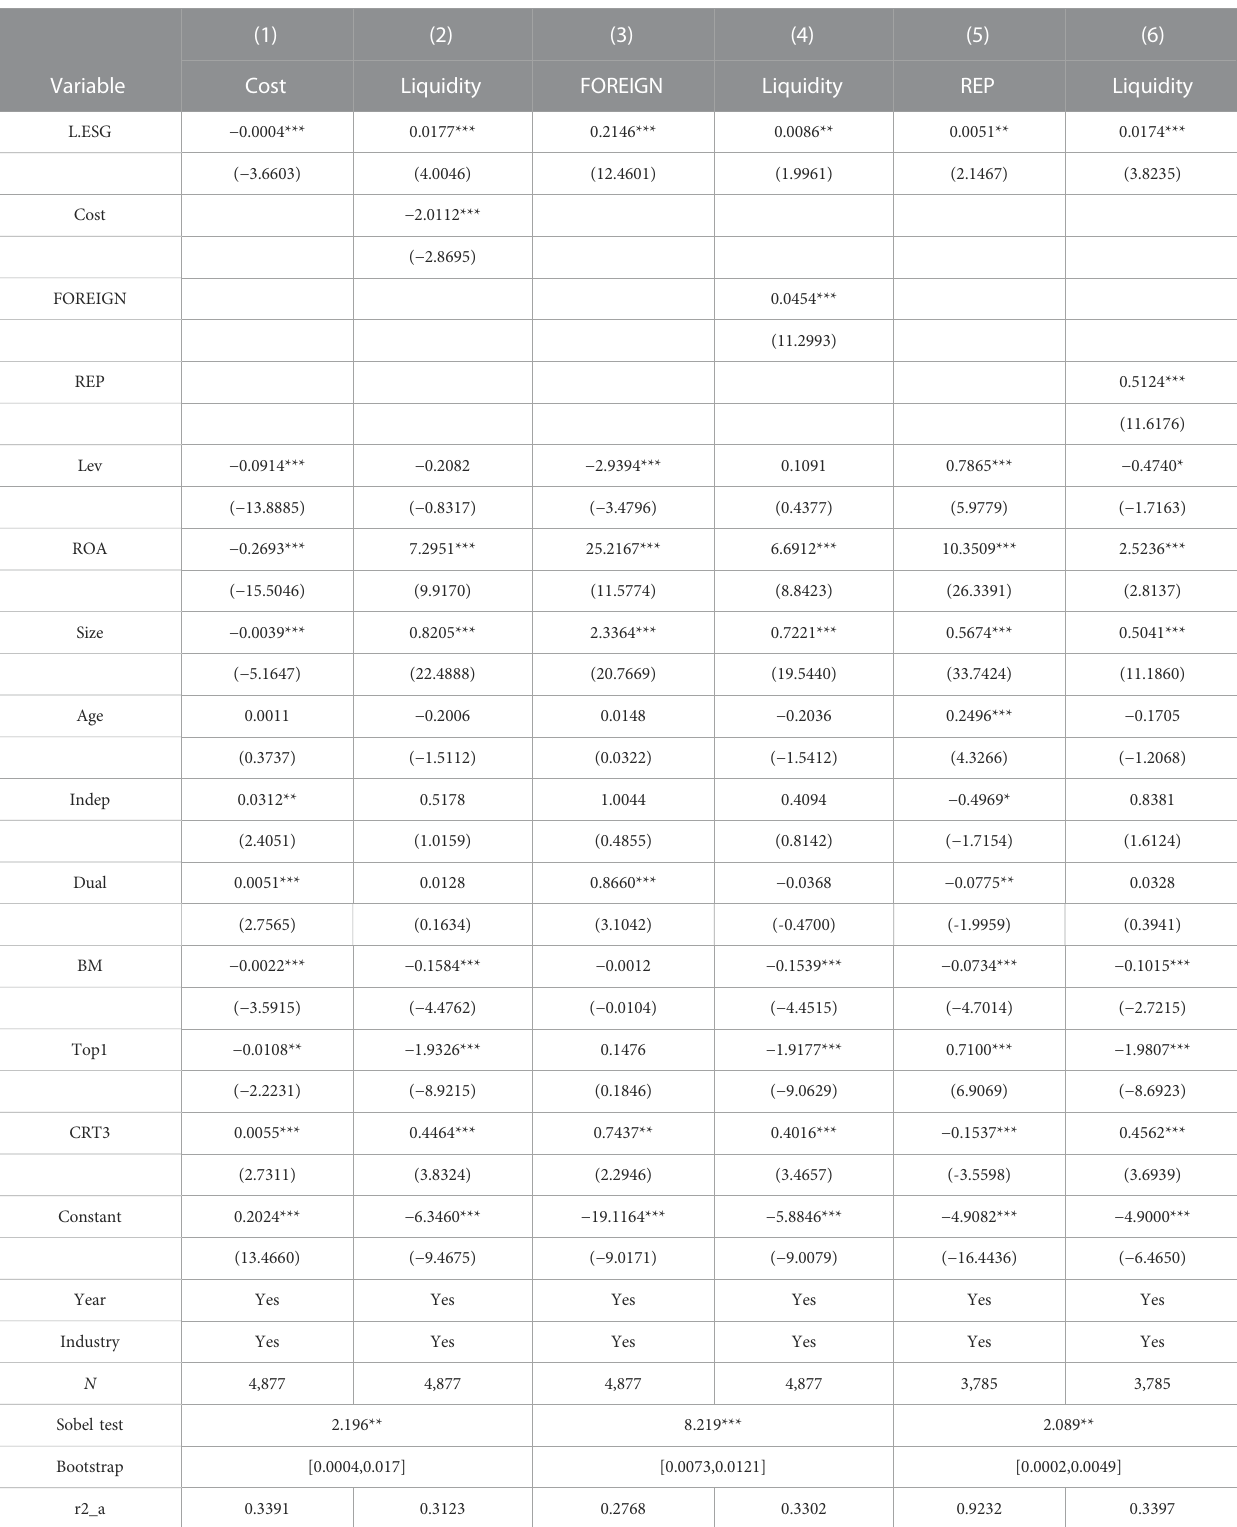
TABLE 8 Mechanism